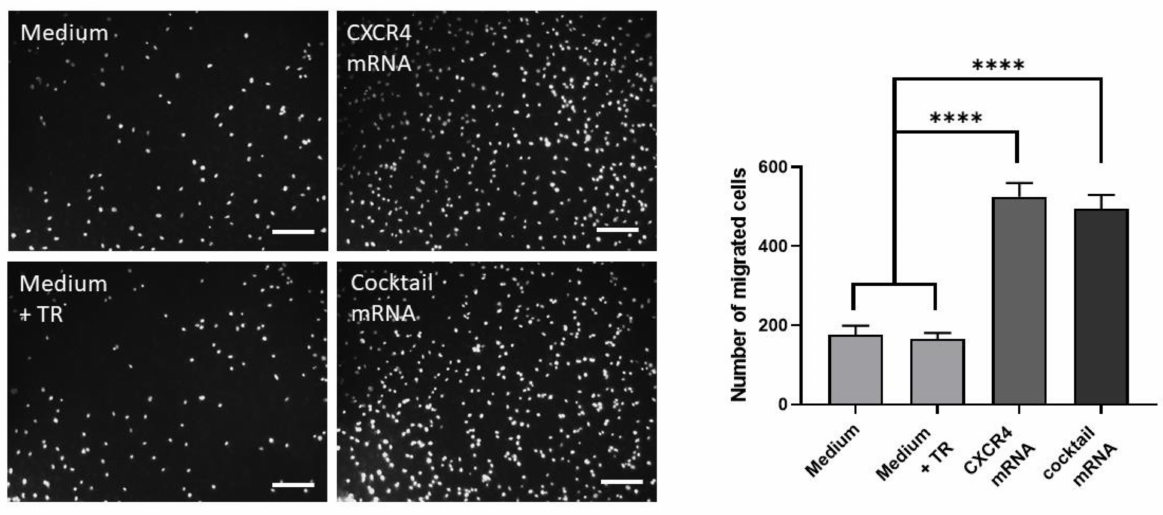
Figure 3. Chemotactic migration of mRNA-modified EPCs. A total of 1 × 10 5 EPCs were trans- fected with either 1 µ g CXCR4 mRNA or with an mRNA cocktail containing 1 µ g CXCR4 and 1 µ g PSGL-1 mRNA. After overnight cultivation, 5 × 10 4 EPCs were seeded in 8 µ m transwell in- serts to analyze their migration capacity towards 50 ng/mL SDF-1 α in a serum-reduced medium. Chemotactic migration was analyzed after 6 h at 37 ◦ C by counting DAPI-stained migrated cells using ImageJ software. As controls, EPCs incubated with medium and medium containing transfection reagent (TR) were used. Scale bars represent 200 µ m. Results are shown as mean + SD ( n = 4). Statistical differences were determined using one-way ANOVA multiple comparisons, followed by Bonferroni ´ s multiple comparisons test (**** p <